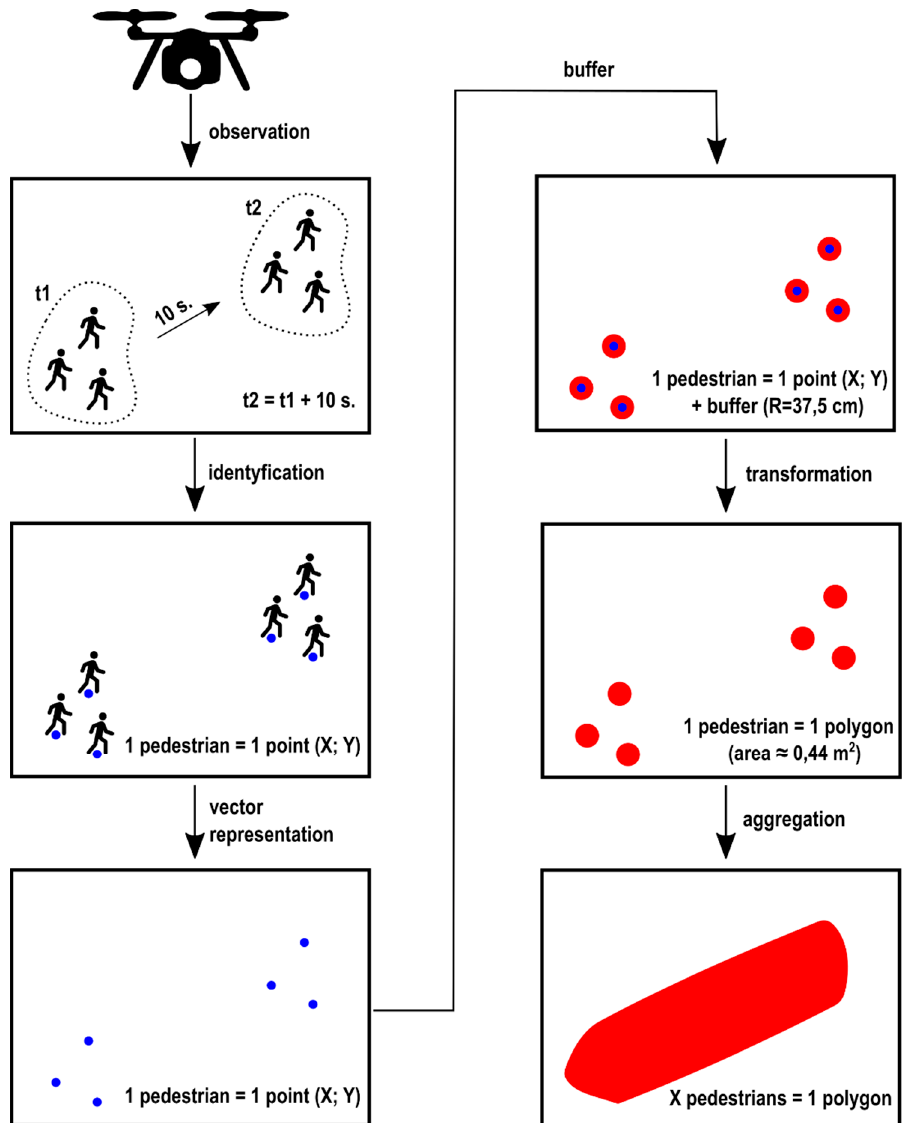
ISPRS Int. J. Geo-Inf. 2020 , 9 , x FOR PEER REVIEW Figure 3. The concept of point-to-polygon transformation of pedestrians’ representation.